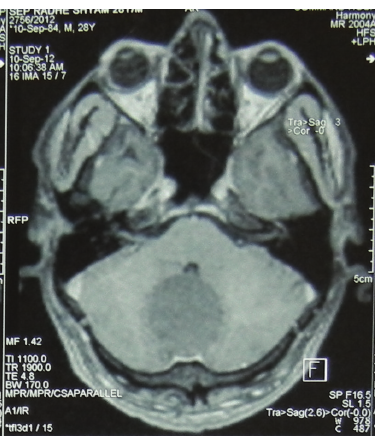
Figure 1: MRI (axial view) Showing mass in posterior fossa.